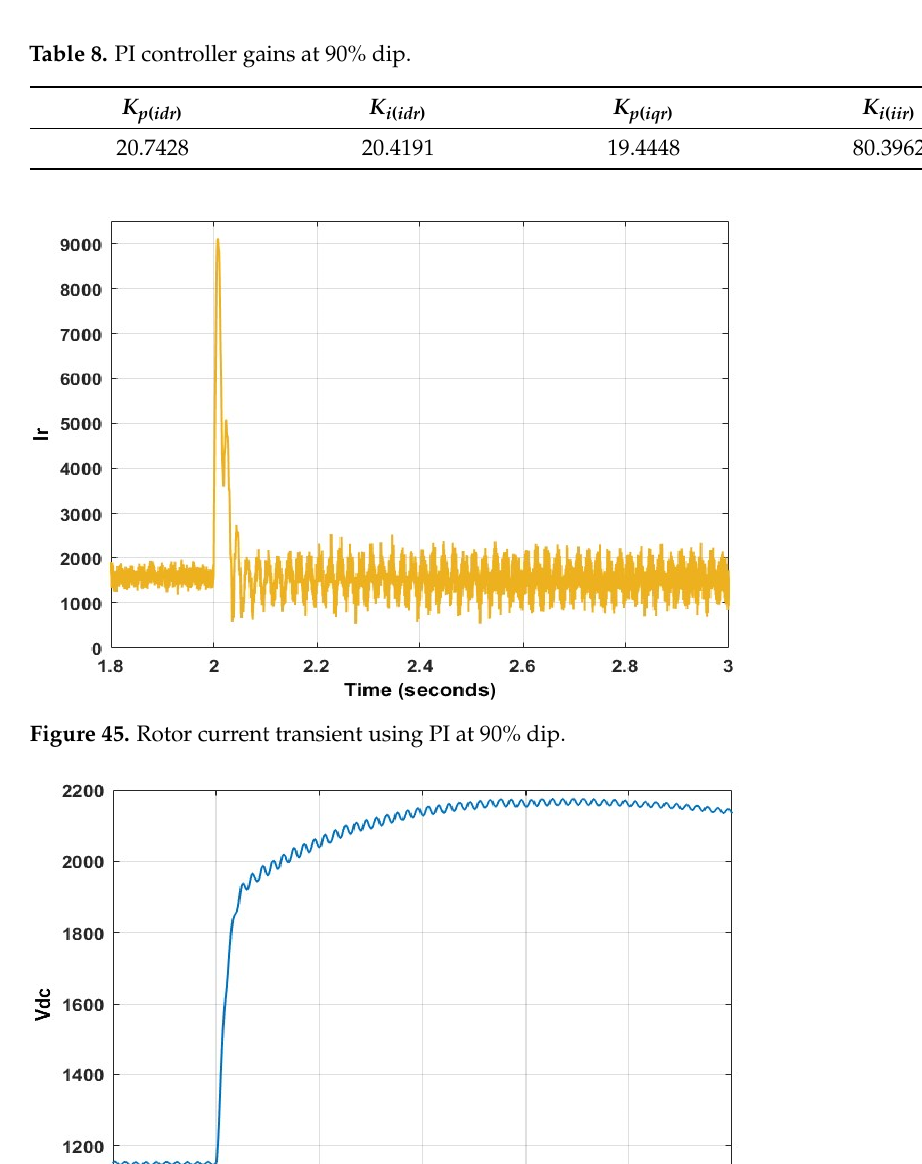
Figure 47. Rotor direct axis current ripple using PI at 90% dip.